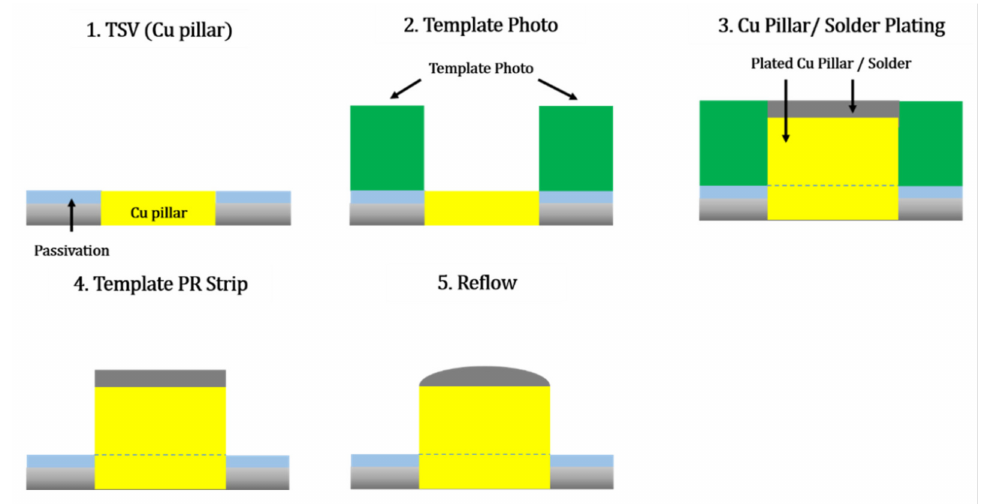
Figure 19. Schematic illustration of the Cu pillar bump with a solder